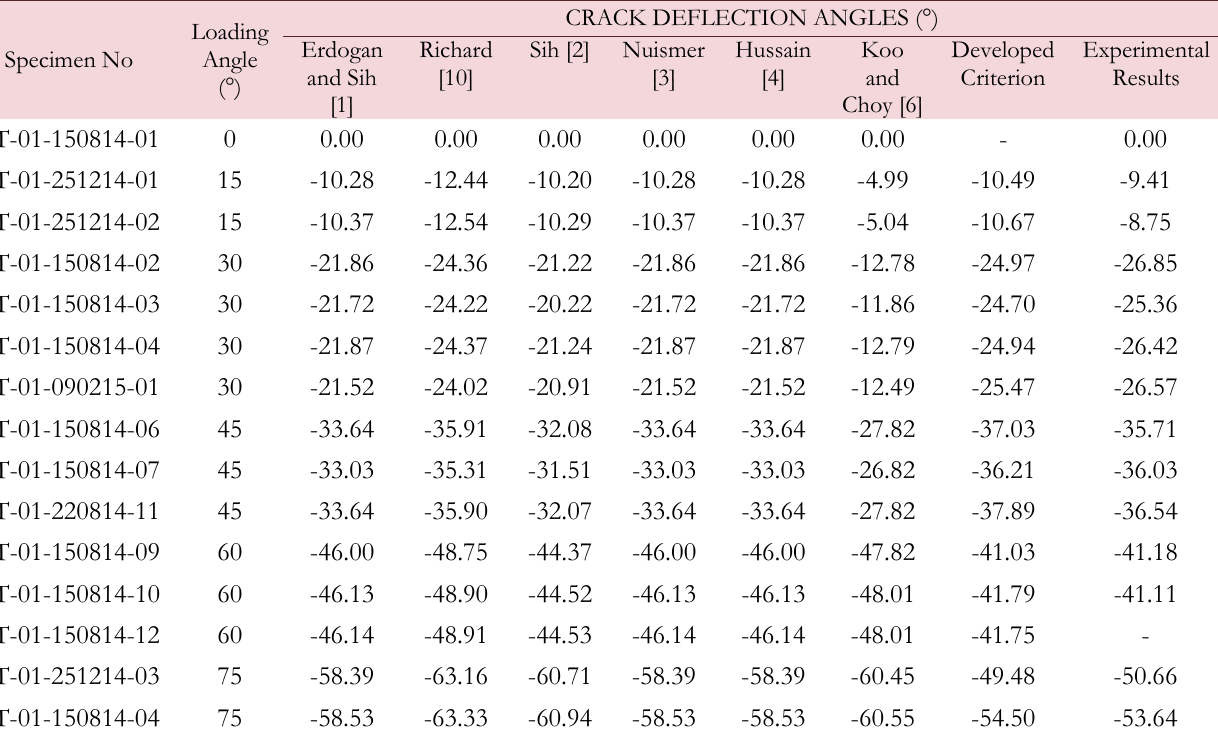
Table 7: Comparison of the predicted crack deflection angles using the developed criterion and comparison with other existing criteria in the literature.